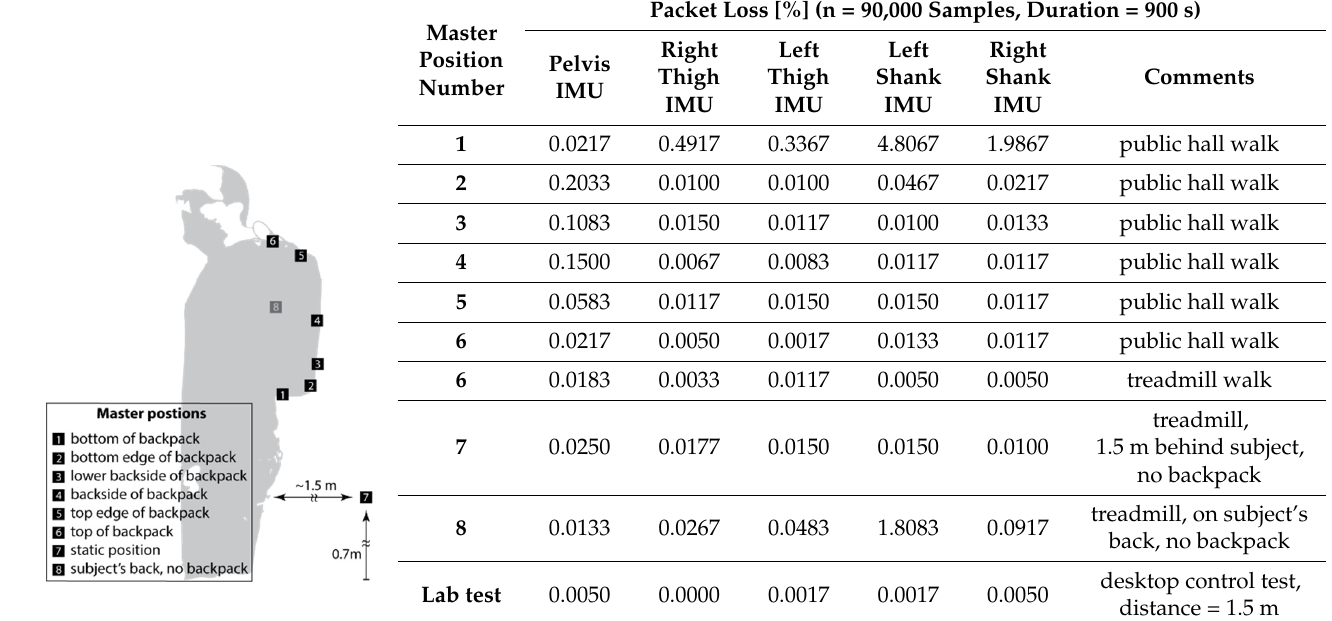
Table 1. Left: (1–6) six points on the backpack where the master unit was placed, 7 and 8 are for the cases without the backpack. Right: table showing percentage packet loss for IMUs placed at the pelvis, right/left thigh, and right/left shank. Master